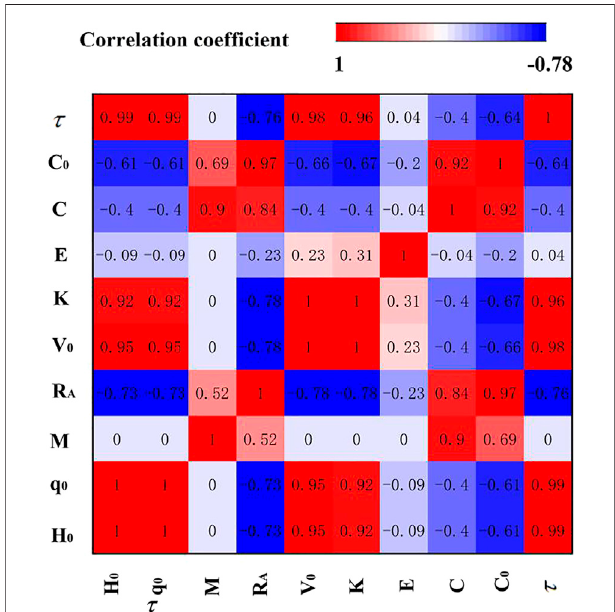
FIGURE 7 | Analysis of factors in fl uencing the deposition rate on basin fl oor.